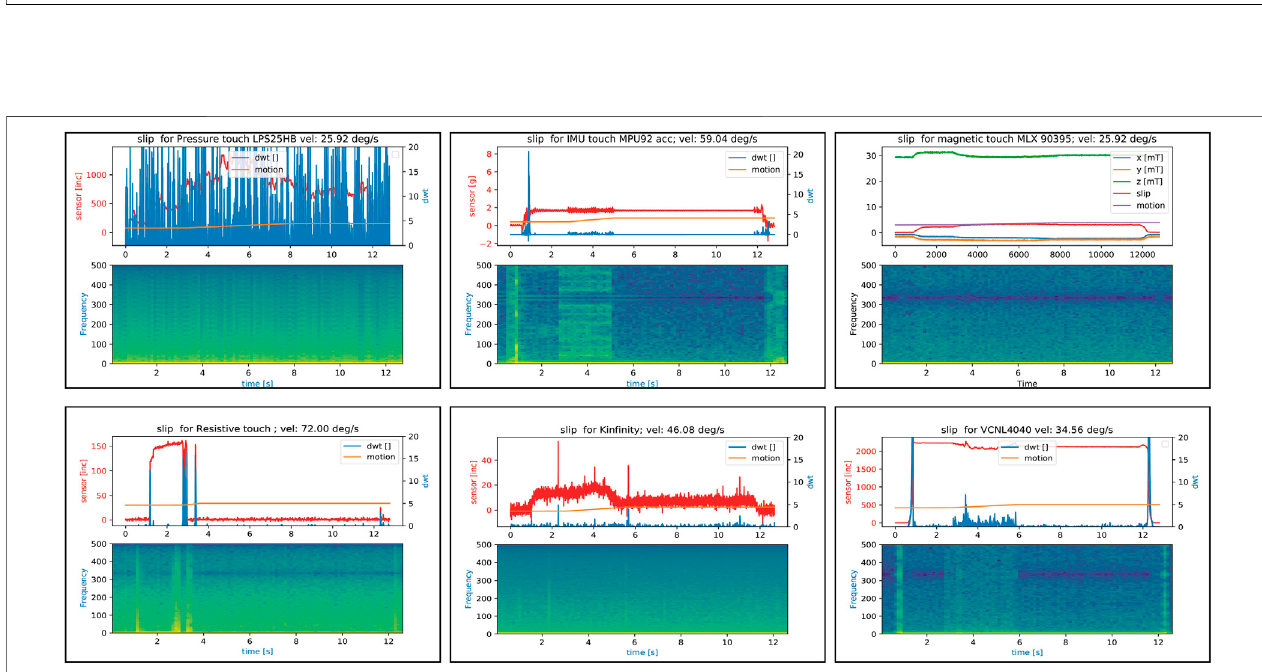
FIGURE 9 | Slippage detection using different sensors. For each sensor we show the raw sensor signal, Discrete Wavelet Transform (DWT) and the motion of the wheelinoneplot,andaspectrogramplotofthesensorsignalintheplotbelow.NotethatforMLX90395insteadoftheDWTweshowaslipsignal,basedon Eq.1 .Ahigh responseinthespectrogramindicatesthatthesignalcanbewelldetectedusingtheDWT,forexample,fortheIMU,whichshowsaclearresponsewhenthewheelstarts to rotate. On the other hand, the Kin fi nity signal is too noisy to differentiate slip from noise.